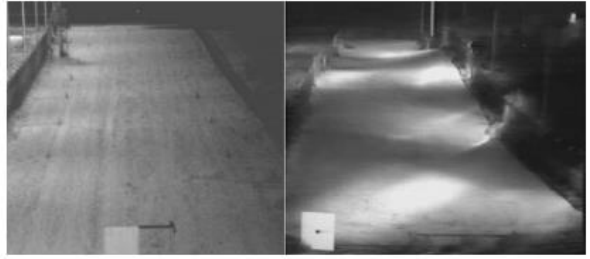
Figure 7. Good and bad night lighting [13]